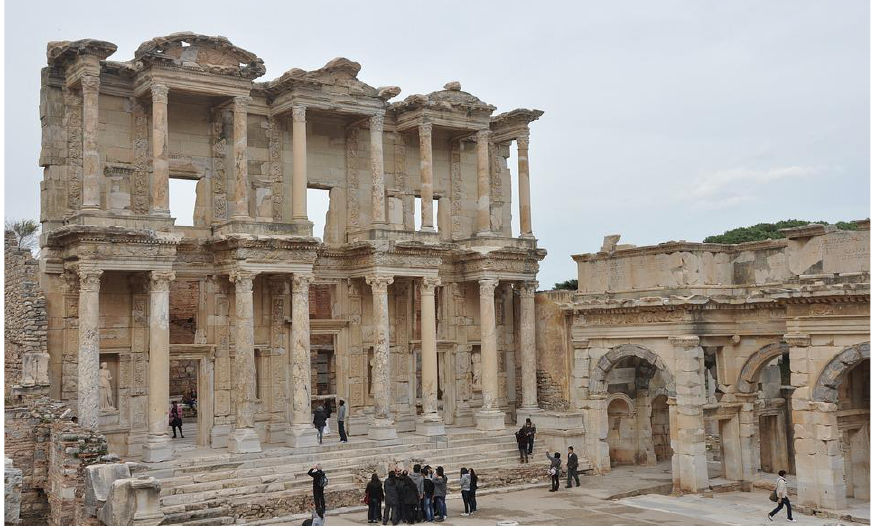
Figure 57. The Roman Library of Celsus. Photo by author.